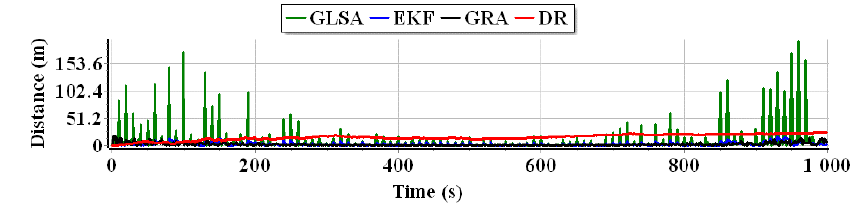
Figure 7. Distance to reference position from estimated position during a single SV crossing as a function of